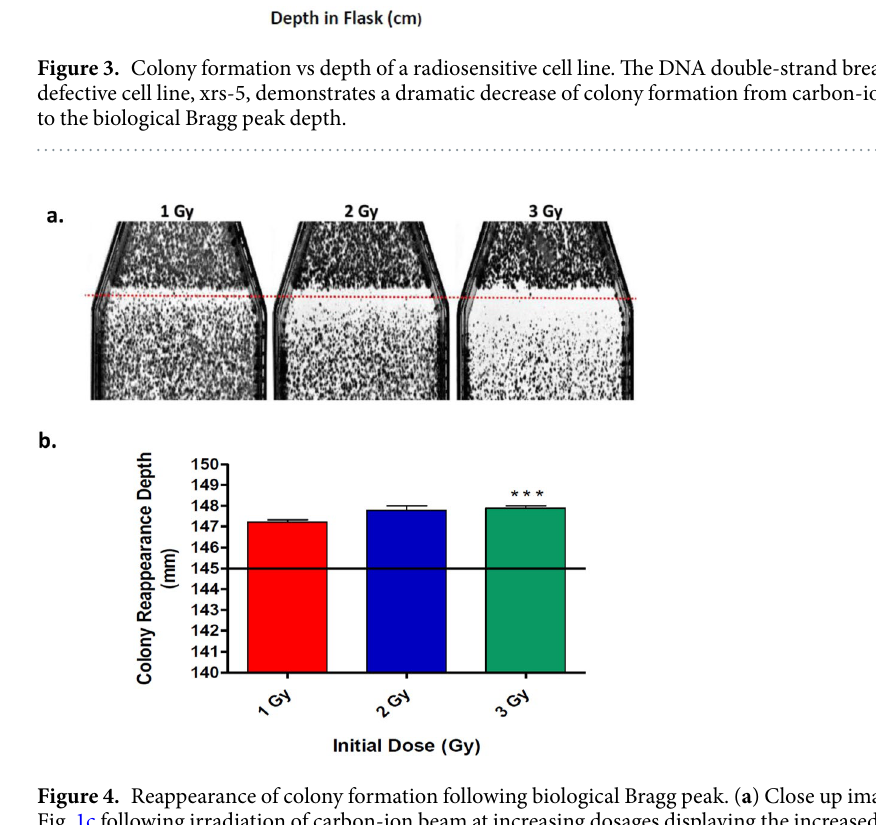
Our results portrayed that micronuclei formation increased in correspondence with an increased depth in the flask up to the evaluated depth of 14.5 cm. As compared to 14.5 cm, the depth of 16.5 cm displayed a signifi- cant decrease in micronuclei formation ( P < 0 . 05 ), with mean values of micronuclei per 150 binucleated cells of 2.865 ± 2.3 to 0.919 ± 0.30, respectively. However, micronuclei formation at any of our evaluated depths was not significant as compared to our control in which cells were not treated with irradiation ( P = 0 . 2088 ). It is important to note that micronuclei formation at the depth of 16.5 cm fell between micronuclei formation at the depths of 2.0 cm and 10.0 cm, with mean values of micronuclei per 150 binucleated cells of 0.837 ± 0.32 and 0.981 ± 0.28, respectively, and 0.919 ± 0.30 for 16.5 cm (Fig. 5b).